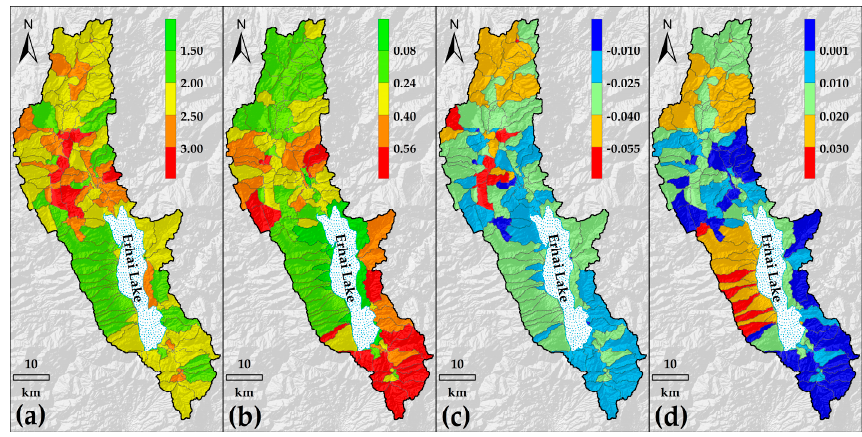
Figure 12. Sensitivity on BWF and GWF impacted by precipitation or temperature change in the sub-basin scale. ( a ) Sensitivity of BWF to precipitation; ( b ) Sensitivity of GWF to precipitation; ( c ) Sensitivity of BWF to temperature; ( d ) Sensitivity of GWF to temperature.